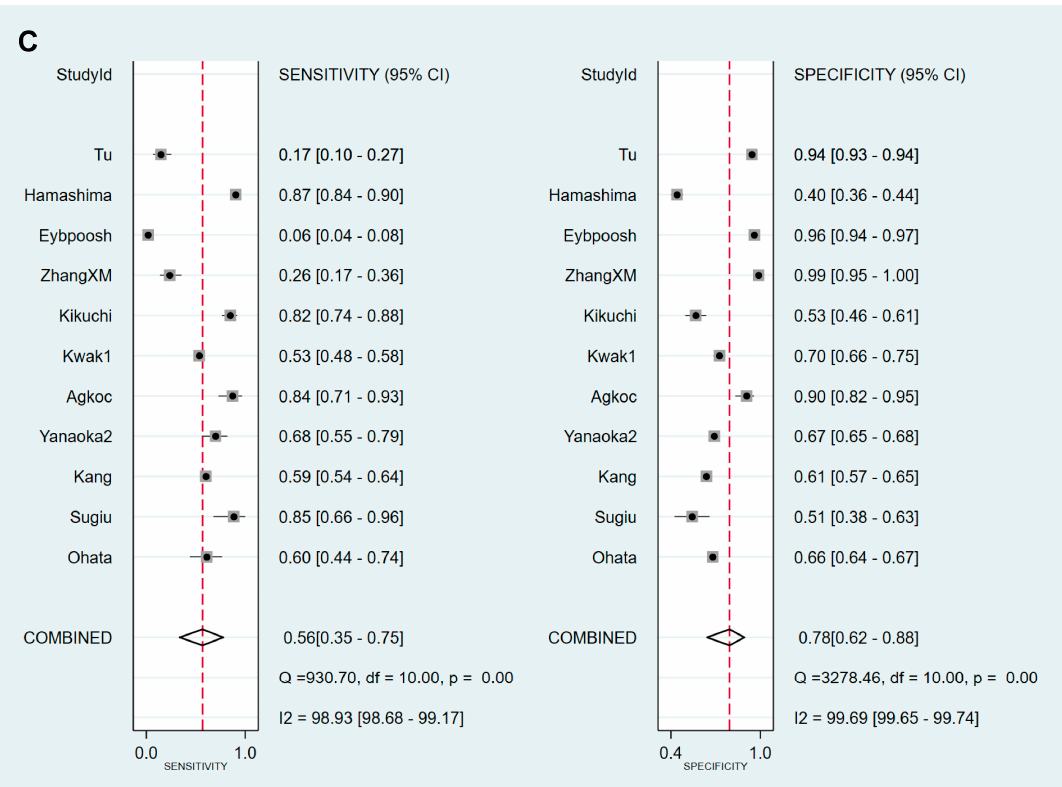
Figure 7. Forest plots of sensitivity and specificity for the diagnosis of GC. ( A ) cut-o ff value with PG I ≤ 70 ng / mL and PG I / PG II ratio ≤ 3, ( B ) cut-o ff value with PG I ≤ 70 ng / mL, ( C ) cut-o ff value with PG I / PG II ratio ≤ 3. GC, gastric cancer; PG, pepsinogen.